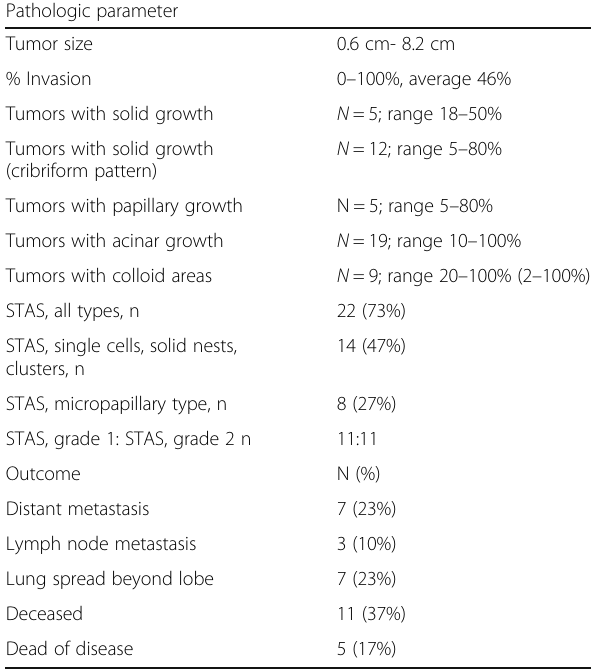
Table 2 Pathologic parameters and